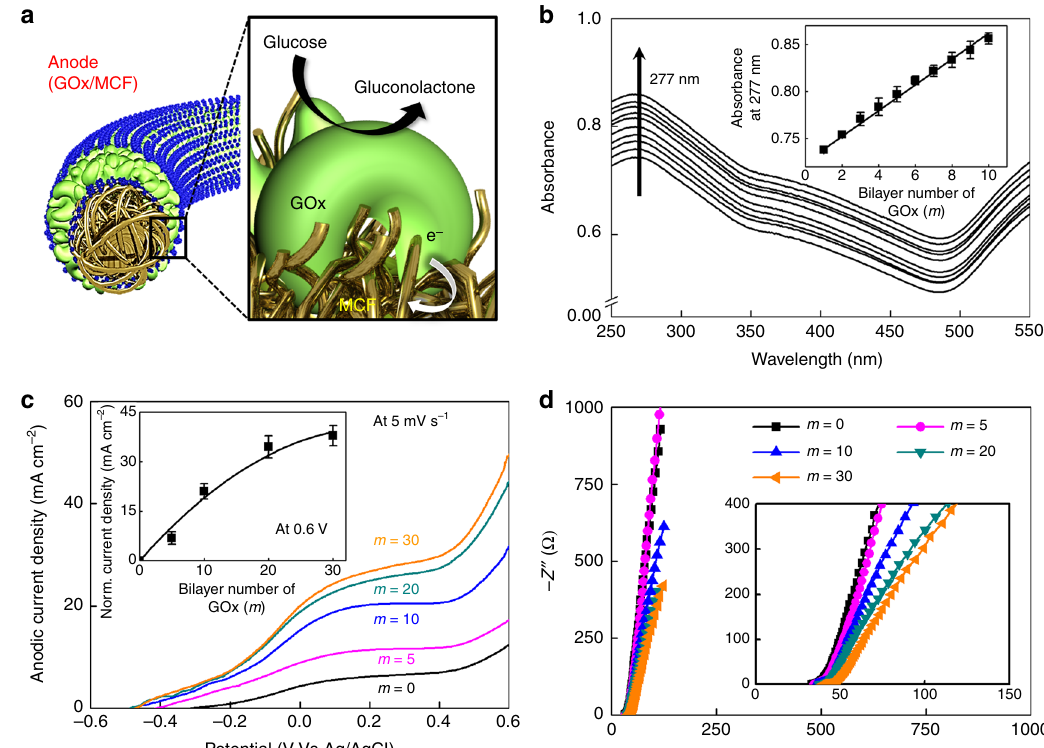
Fig. 3 Electrochemical properties of biofuel cell anode. a Illustration of the anode fi bers composed of m -bilayered glucose oxidase ( m -GOx)/20-bilayered metallic cotton fi bers (20-MCF). b Ultraviolet-visible (UV − Vis) spectra of the GOx/tris-(2-aminoethyl)amine (TREN) m multilayers. Inset: hyperchromicity of the multilayers at 277 nm. c Anodic current density curves of the (GOx/TREN) m /20-MCF electrode. Inset: the change in the normalized anodic current density levels at + 0.6 V; here, the normalized level is de fi ned as the current density level for which the anodic current density level of 20-MCF ( m = 0, black curve) is subtracted from the anodic current density level of m -GOx/20-MCF at the speci fi c potential of + 0.6 V. The error bars show the standard deviation from the mean value of current densities for 3 − 5 independent experiments. d Nyquist curves for (GOx/TREN) m /20-MCF NATURE COMMUNICATIONS| (2018) 9:4479 |DOI: